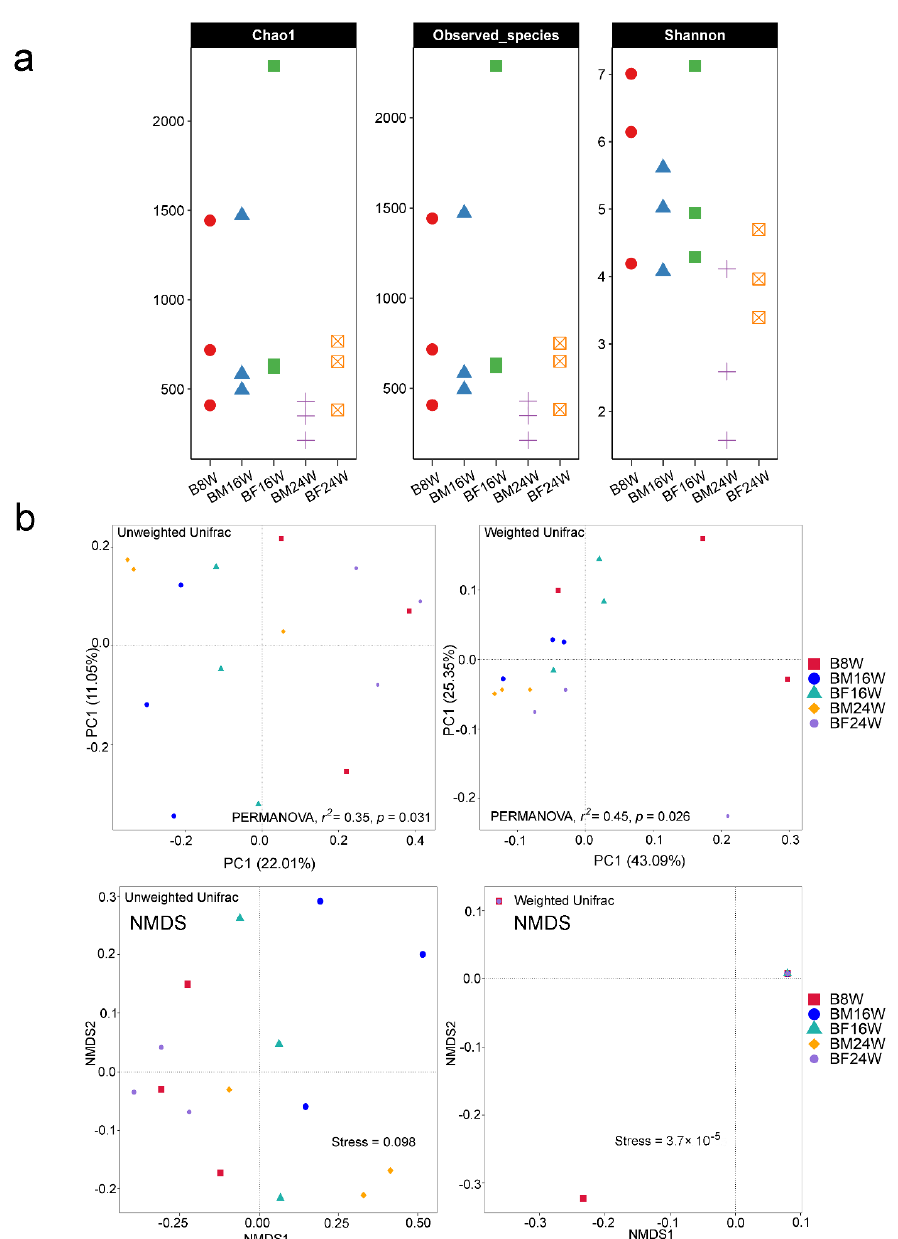
Figure 1. Gut microbiota diversity in Siamese fighting fish across age and gender groups. ( a ) Boxplots of alpha diversity of Siamese fighting fish gut microbiota across age and gender groups. Alpha diversity index was calculated based on Chao1, observed species, and Shannon indices. ( b ) Siamese fighting fish gut microbial community structure and composition across age and gender groups. PCoA plots of unweighted and weighted UniFrac distances, respectively. A difference in microbial communities across groups was determined by PERMANOVA. NMDS plots of gut microbiota based on unweighted and weighted UniFrac distances, respectively. The closer the stress value is to 0, the better the original data points are represented in the reduced dimensions. The distances between the sample points represent the dissimilarity of their microbiomes. B8W, 8-week-old Siamese fighting fish; BM16W, 16-week-old male Siamese fighting fish; BF16W, 16-week-old female Siamese fighting fish; BM24W, 24-week-old male Siamese fighting fish; BF24W, 24-week-old female Siamese fighting fish.